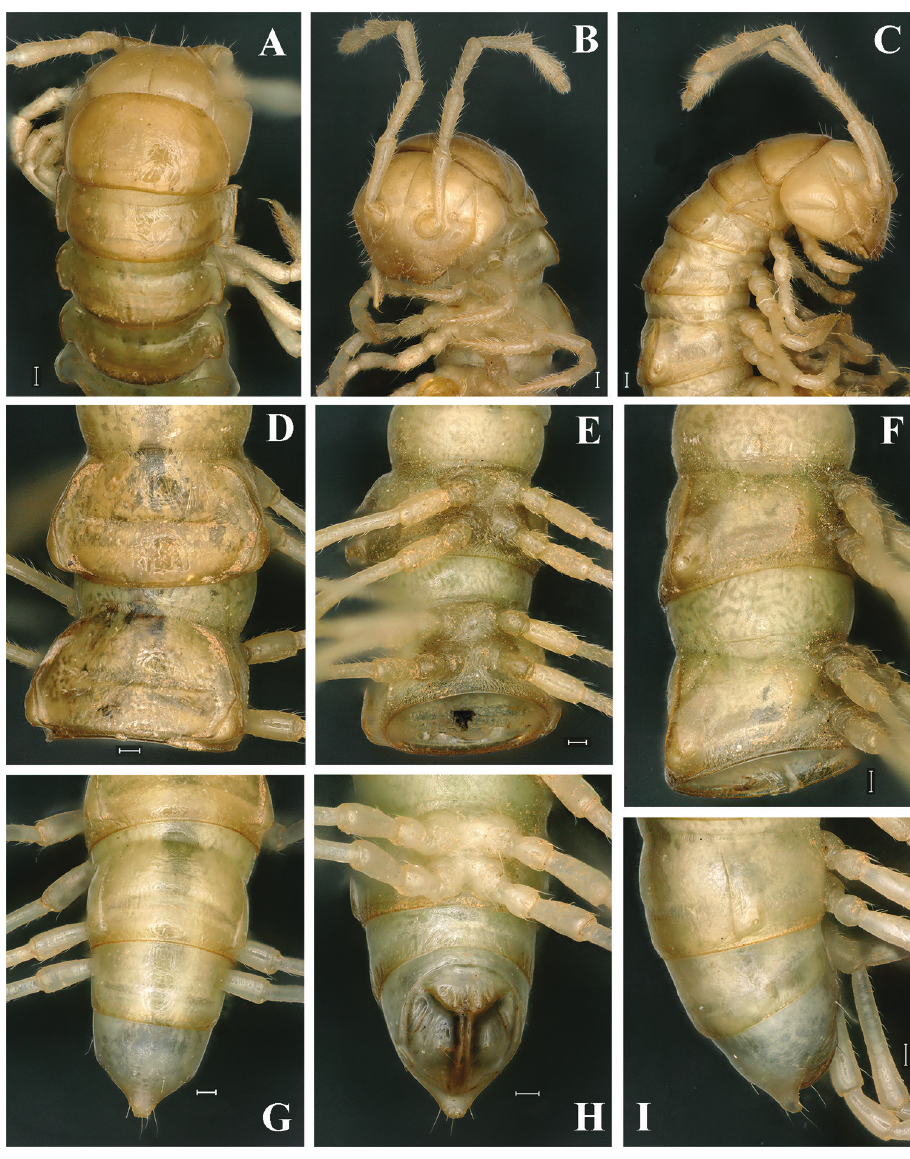
Figure 5. Tonkinosoma tiani sp. n., ♂ paratype from Ganhan Cave. A–C anterior part of body, dorsal, ventral and lateral views, respectively D–F midbody segments; dorsal, ventral and lateral views, respec- tively G–I posterior part of body, dorsal, ventral and lateral views, respectively. Scale bar: 0.2 mm. Paraterga of collum small, but evident, rounded. Paraterga 2 well-developed, directed down, with 4–5 clear lateral incisions on each side, frontolateral corner much sharper (Fig. 5A). Paraterga 3–6 each with three small, lateral incisions (Figs 5A), following paratergal incisions indistinct (Figs 5D, G, 6A). Calluses of paraterga 5–18 very